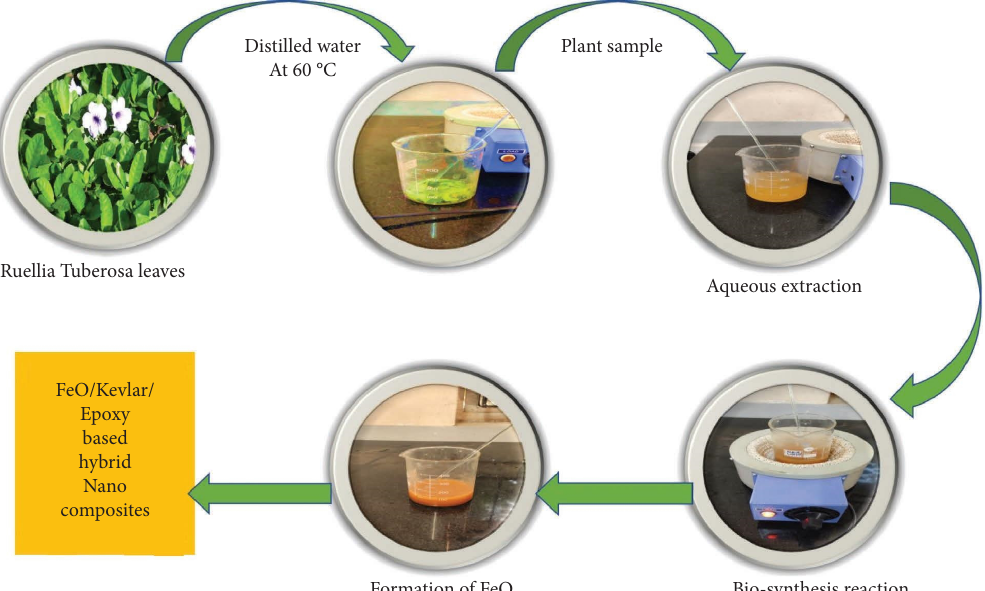
Figure 1: Bio-synthesis of FeO from Ruellia tuberosa leaves.